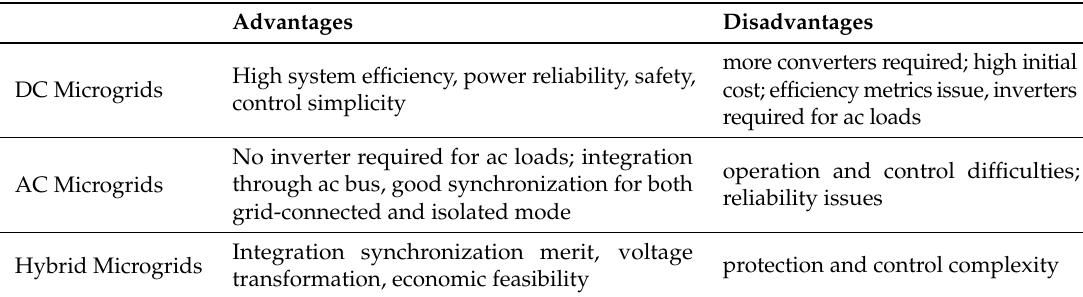
Table 1. Features of the microgrid